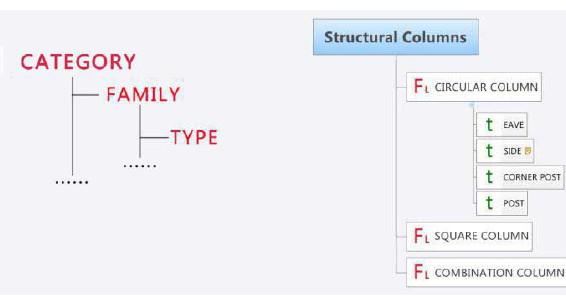
Figure 9. The type tree of 3 rd